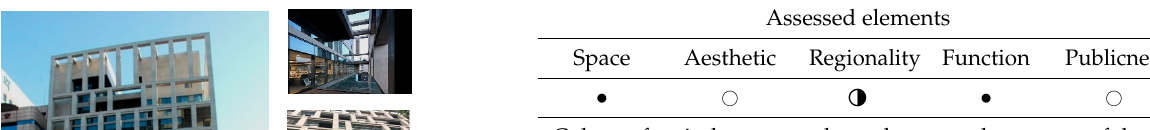
(cid:35) Column-free indoor space through outward exposure of the